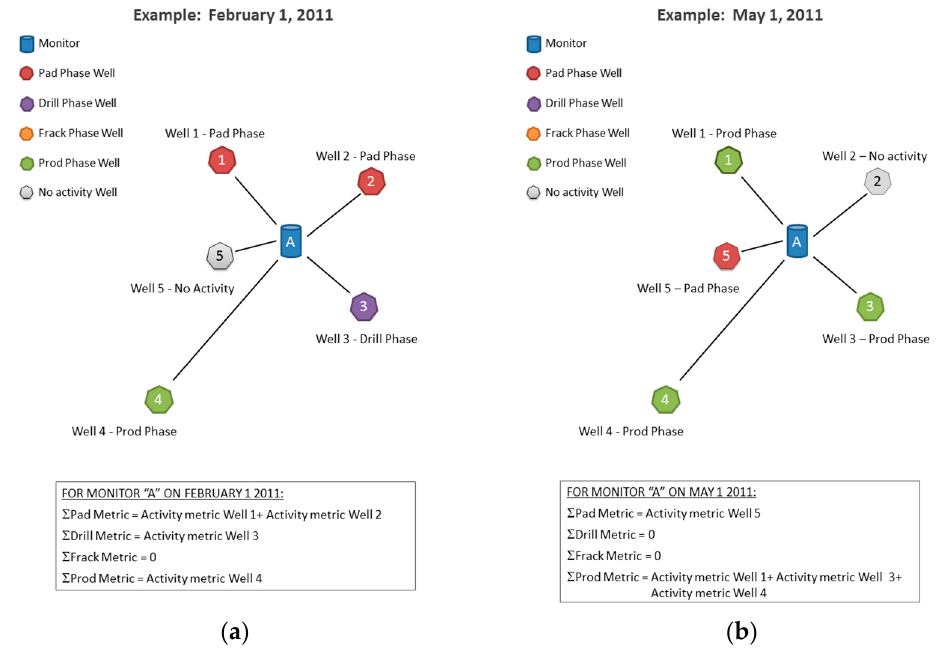
Figure 3. Illustration of the method used to calculate daily WA metrics on sample dates of ( a ) 1 February 2011 and ( b ) 1 May 2011 using air monitors as simulated study subject residences.